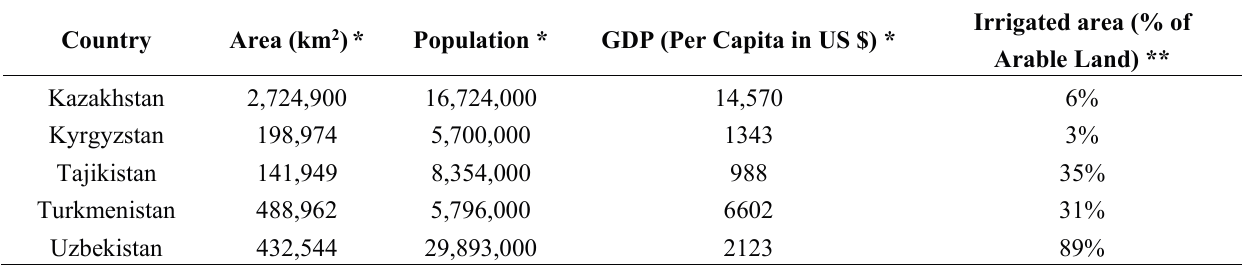
Table 1. States of Central Asia—basic